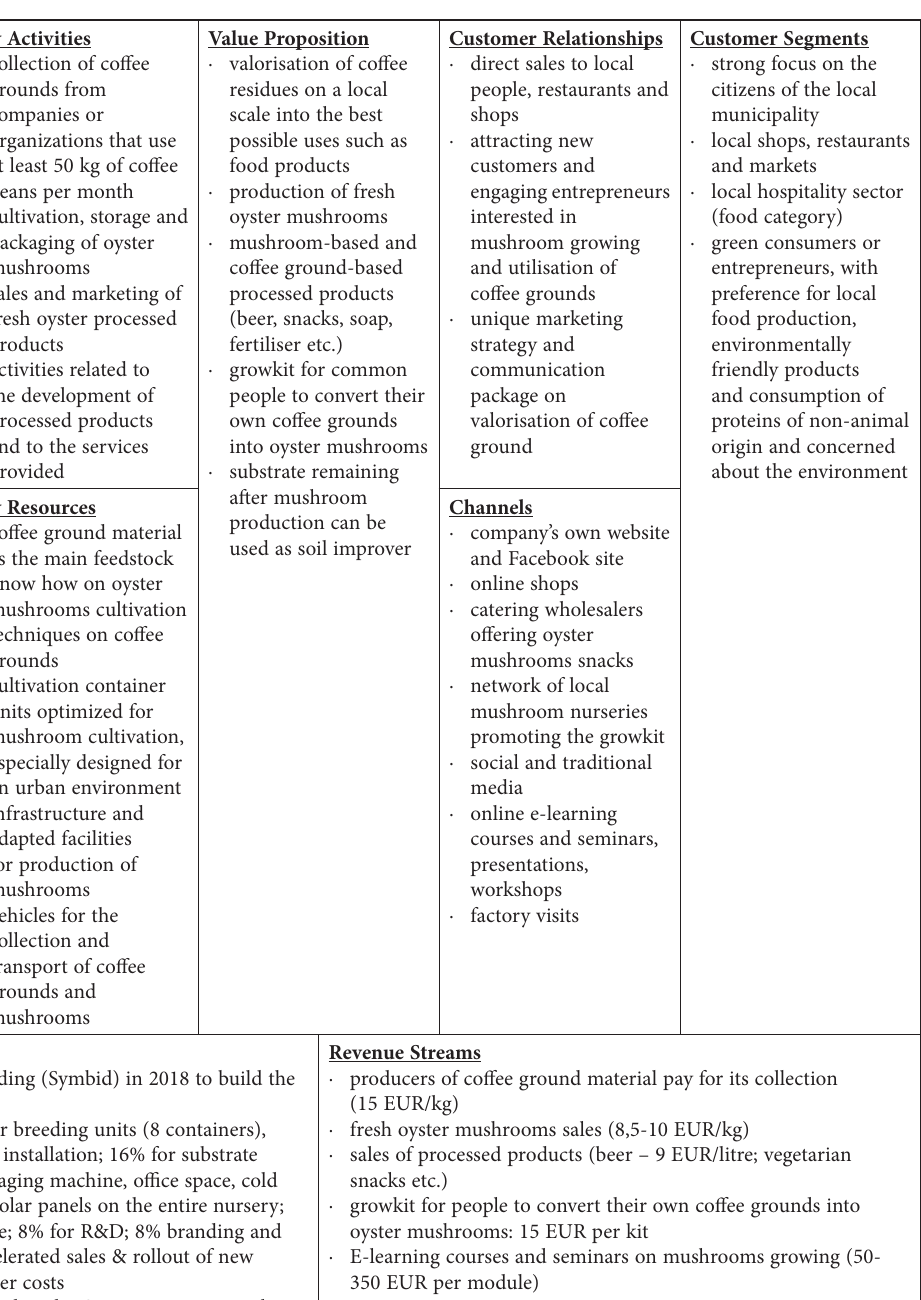
Figure 4. BMC of solution ‘S2’ (Rotterzwam B.V., The